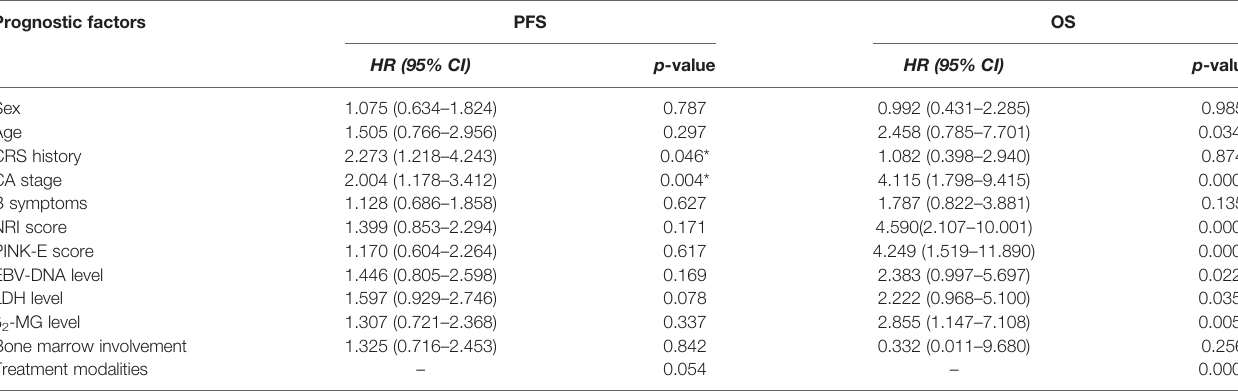
TABLE 4 | Univariate analysis of prognostic factors for PFS and OS. Prognostic